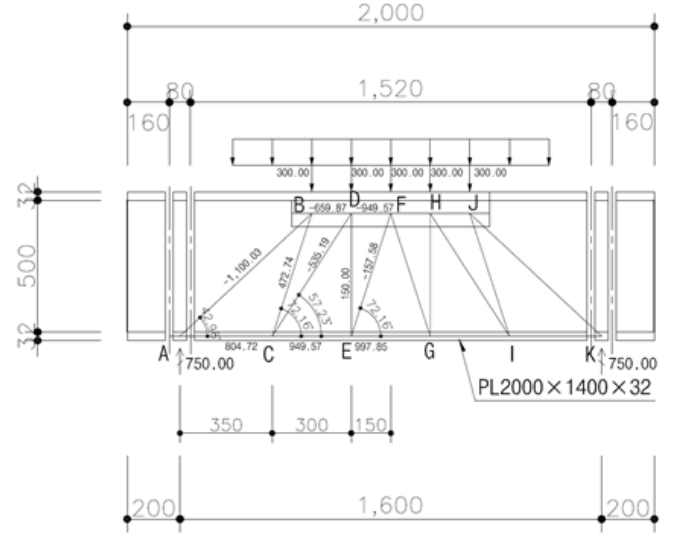
Figure 6. Strut-and-tie model (STM) of anchor block for pre-tensioning (Unit: mm).